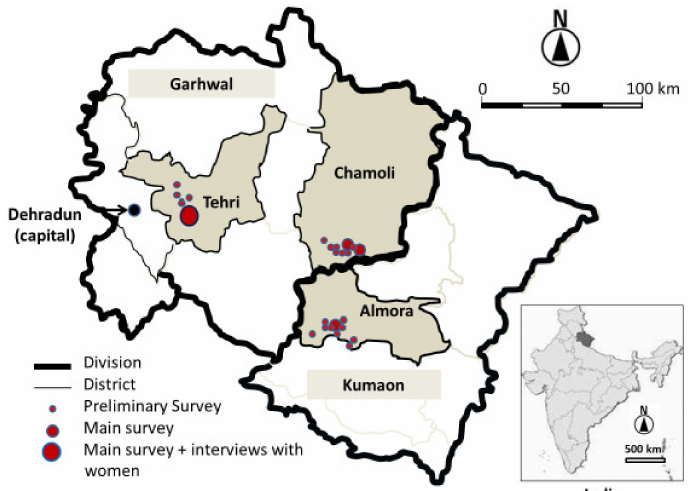
Figure 4. State of Uttarakhand, India (study